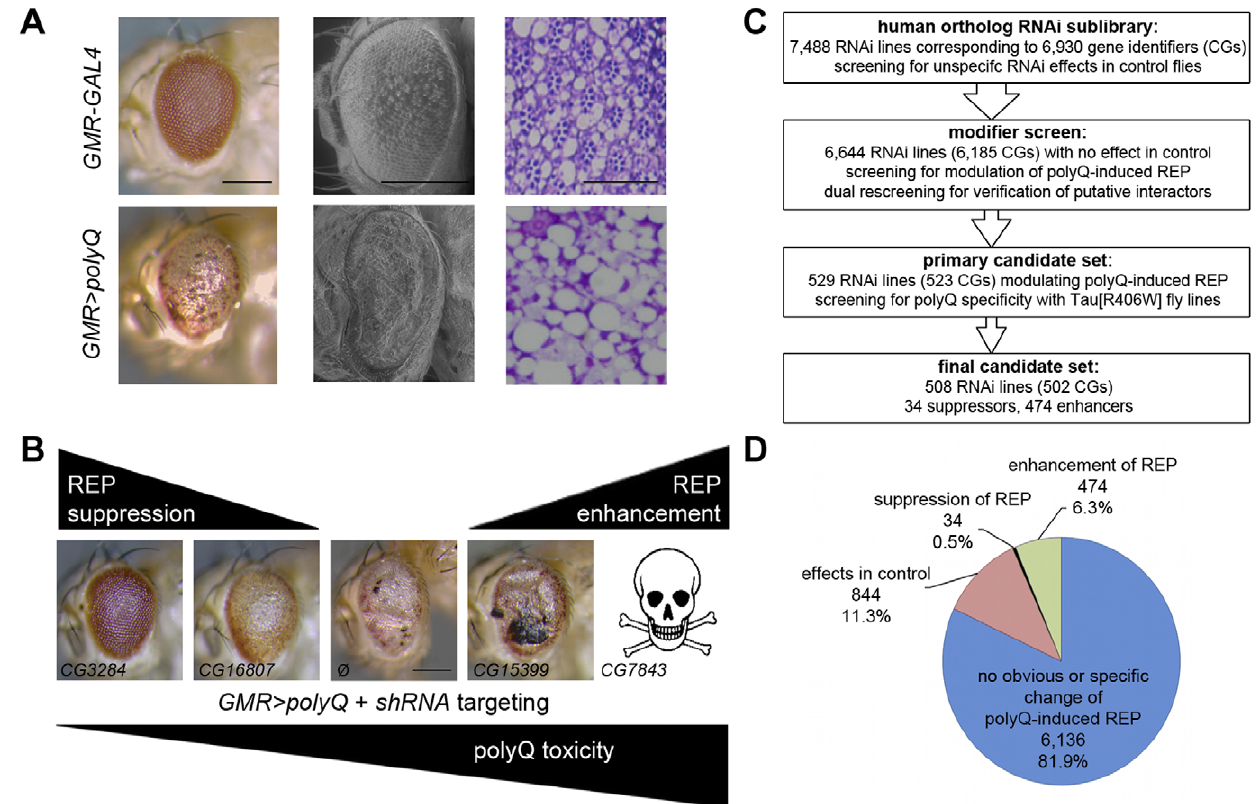
Figure 1. Screening for modifiers of polyQ-induced toxicity. ( A ) Rough eye phenotype (REP) used as a primary readout for screening. Compared to control (upper panels), eye-specific ( GMR-GAL4 ) expression of polyQ (lower panels) induces disturbances of the external eye texture, e. g. depigmentation of the compound eye observed by light microscopy (left) and as depicted in scanning electron micrographs (middle). Toluidine blue-stained semi-thin eye sections reveal that the disturbance of external eye structures is accompanied by degeneration of retinal cells (right). ( B ) Modification of the polyQ-induced REP by enhancers and suppressors. VDRC transformants used to silence respective genes: CG3284 (11219), CG16807 (23843), CG15399 (19450) and CG7843 (22574). ( C ) Flow chart of the screening procedures to identify modifiers of polyQ-induced toxicity. ( D ) Brief summary of screen results. Scale bars represent either 200 m m in eye pictures or 50 m m in semi-thin eye sections.